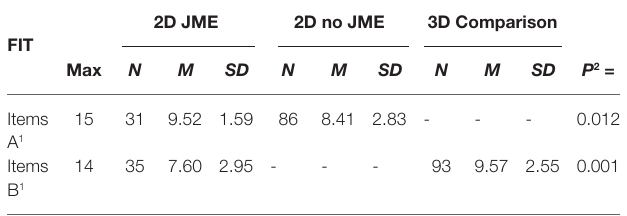
TABLE 3 | Recall memory scores on the Frankfurt Imitation Test (FIT) for the JME intervention groups and the opportunistic comparison group being tested with half the items 3D and half